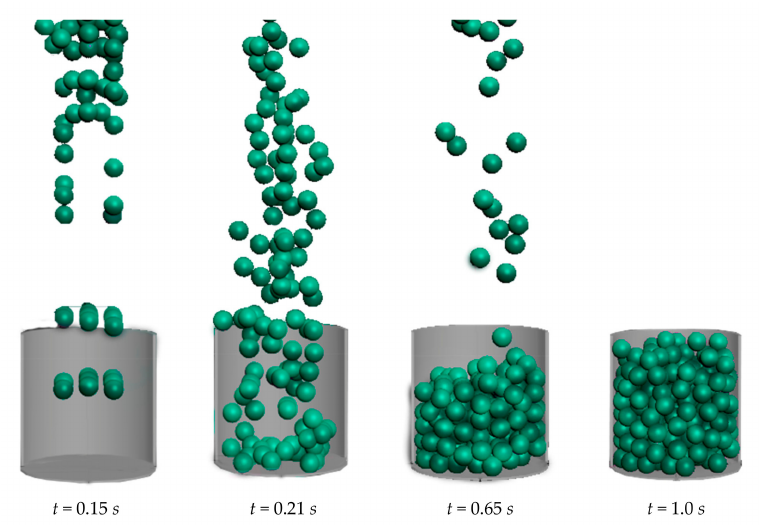
Figure 1. An example of a filter model created by pouring spherical granules into a cylindrical area; the dynamics are in the time interval t = 0.15–1.0